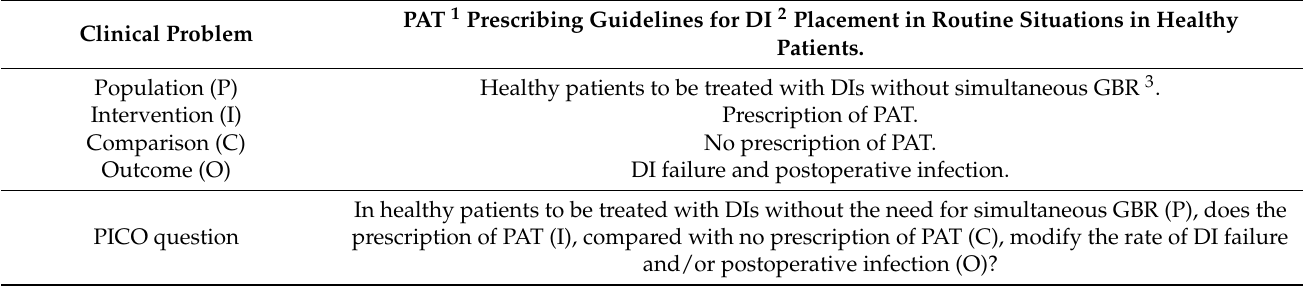
Clinical Problem